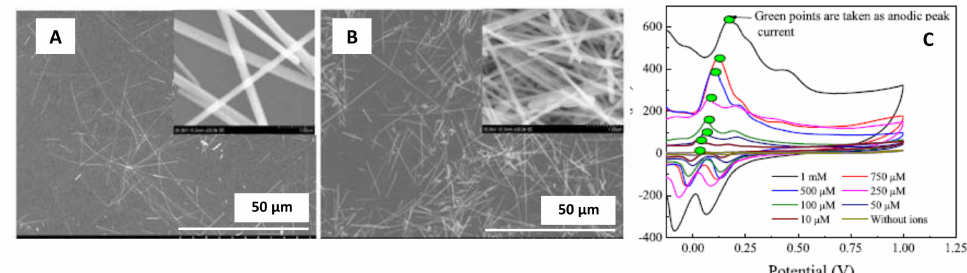
Figure 10. ( A ) SEM micrograph of ammonium molybdate tetrahydrate (AMT)/silver nanowires (AgNWs) for a reaction time of 10 min. ( B ) (AMT)/silver nanowires (AgNWs) for a reaction time of 16 min. ( C ) Cyclic voltammograms obtained for the AMT/AgNWs modified screen-printed electrodes for phosphate detection using 0.1 M H 2 SO 4 /KCl electrolyte. Reproduced with permission of Kabir et al., IEEE Sensors Journal; published by IEEE, 2018